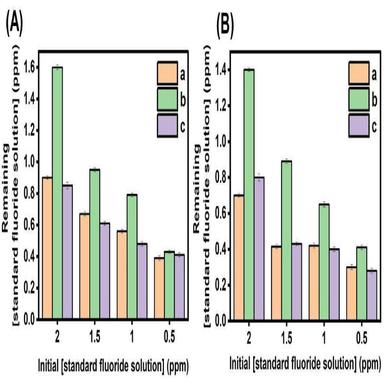
Fluoride removal under (A) dynamic and (B) static conditions from (a) ACC (b) Cu-ACC and (c) 90% of ACC & 10% of Cu-ACC mixture.